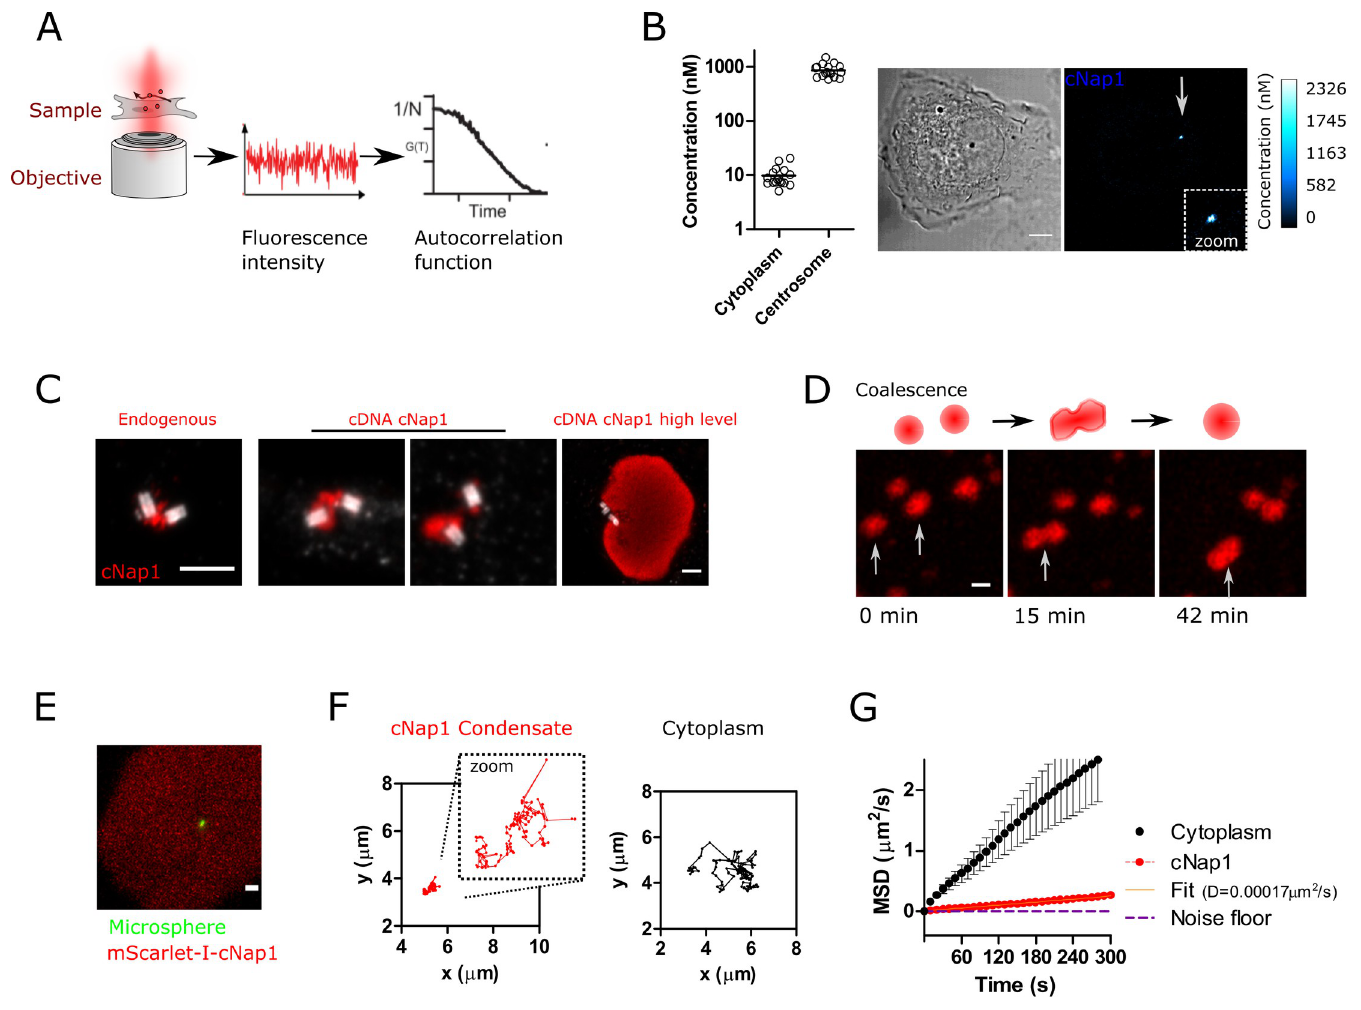
Fig 3. cNap1 forms viscous condensates. ( A ) Schematic of FCS measurements. Fluorescence fluctuations within a confocal volume are converted into absolute concentrations using the FCS autocorrelation function and measurements of the confocal volume size. Image intensities are converted from arbitrary fluorescence intensities into concentration maps. ( B ) FCS-calibrated imaging of homozygously tagged endogenous cNap1-mScarlet-I, either in the cytoplasm or the centrosome of U2OS cells. The representative image shows a single cell, coloured relative to cNap1 concentration. Scale: 5 μ m. The dot plot horizontal lines show the mean from a population of cells and each dot represents a single cell. ( C ) Comparative U-ExM of endogenous cNap1 and cDNA-expressed cNap1. Each panel shows a different cell and cNap1 is shown in red. Centrioles are marked by anti-acetylated tubulin staining (white). Scale: 1 μ m throughout. The panels show different sized areas. ( D ) Live-cell time- lapse imaging of mScarlet-I-cNap1, showing coalescence. Maximum intensity projections are shown. Scale: 1 μ m. ( E ) Green fluorescent microsphere (green) embedded within mScarlet-I-cNap1 (red). A single z-slice is shown. Scale: 1 μ m. ( F ) Two example trajectories of bead movement when either embedded in cNap1 (left, red) or in the cytoplasm (right, black). ( G ) MSD of microspheres embedded in cNap1 (red) or in the cytoplasm (black). The lines show weighted means ( ± SEM) from N = 51 (transfected, condensate) and N = 43 (untransfected, cytoplasm) tracks taken in 3 independent experiments. The orange line shows the fit from which the diffusion coefficient of 0.00017 μ m 2 /s was calculated (R 2 = 0.996). The noise floor is plotted as a dashed purple line, obtained through measurement of immobilised beads with the same imaging conditions. The data underlying the plots can be found in S1 Raw Data. FCS, fluorescence correlation spectroscopy; MSD, mean squared displacement; U-ExM, ultra-expansion